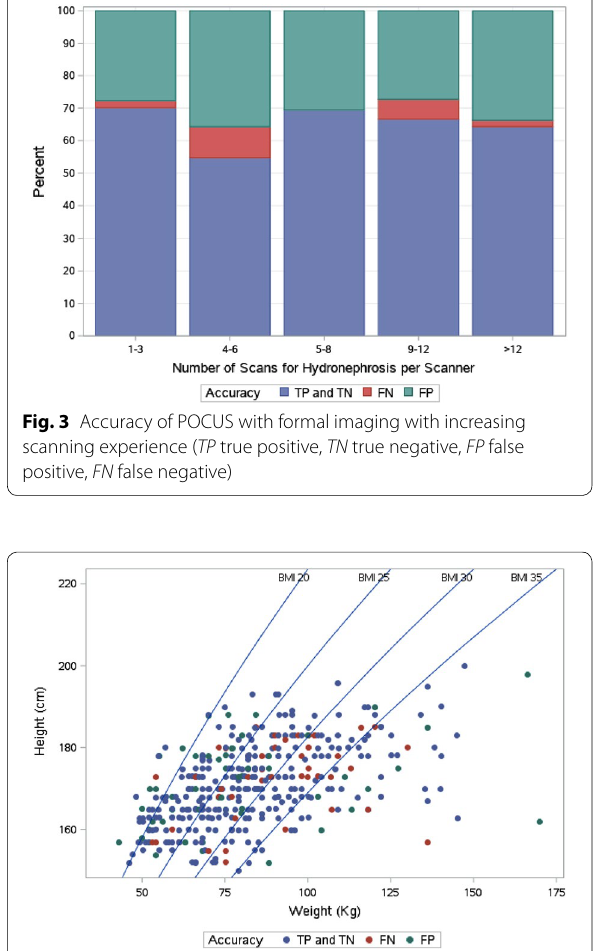
Fig. 4 Accuracy of POCUS for the detection of hydronephrosis relative to patient BMI ( TP true positive, TN true negative, FP false positive, FN false